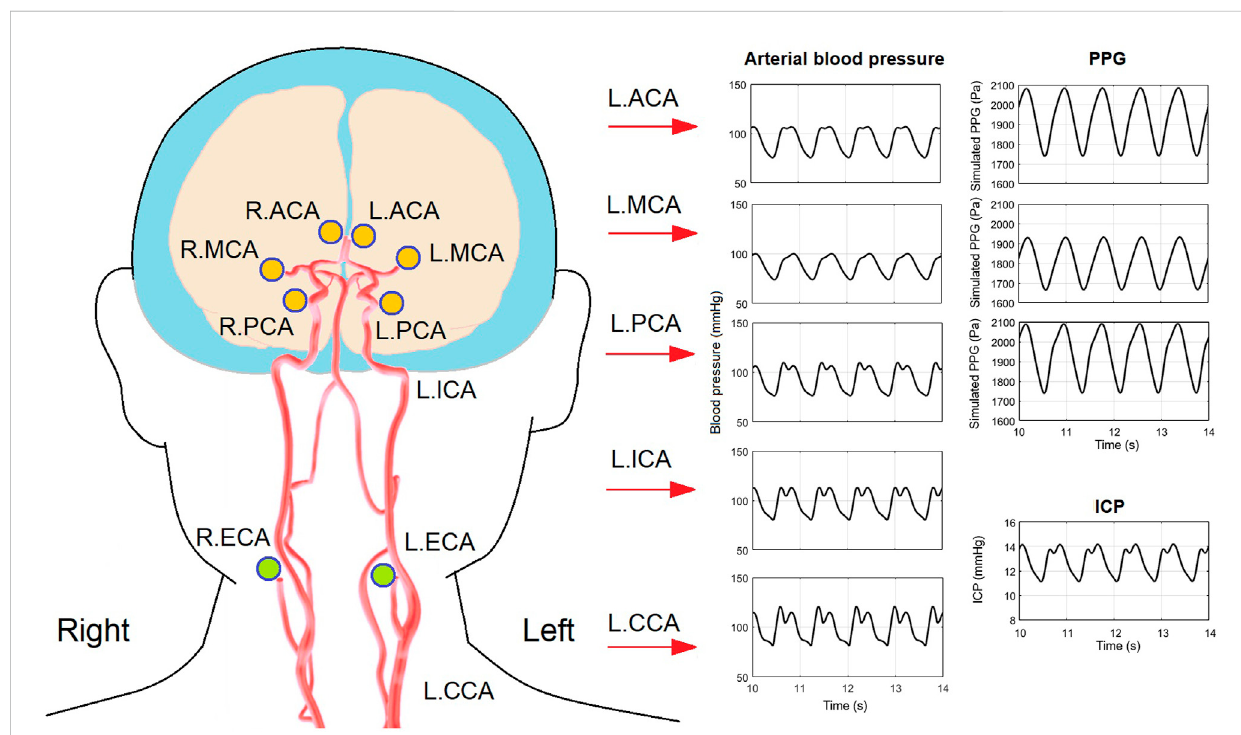
FIGURE 7 Arterial blood pressure, PPG, and ICP waveforms in a 40-years old subject with 20% decrease of intracranial capacitance. The illustration of artery structure is adapted from (Kang et al., 2021).